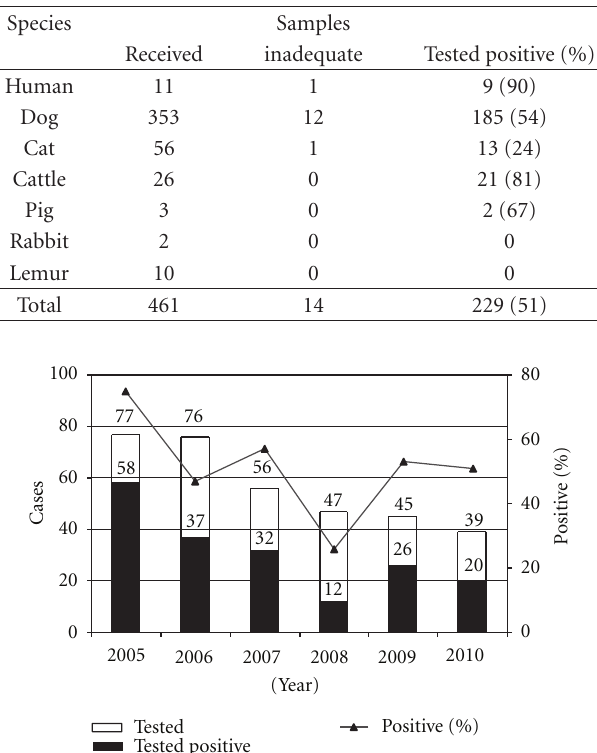
Table 1: Rabies laboratory diagnostic in human, domestic and tame wild animals, Madagascar, 2005–2010.